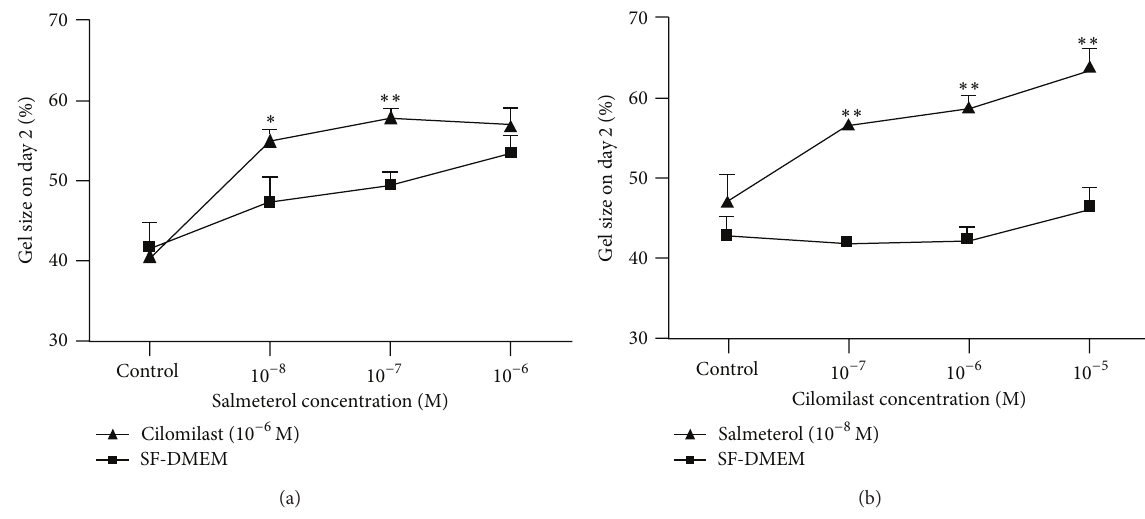
Figure 2: Cilomilast potentiates the inhibitory effect of salmeterol on fibroblast-mediated collagen gel contraction. (a) Effect of cilomilast on varying concentrations of salmeterol. HFL-1 cells were cast into collagen gels and released into SF-DMEM containing varying concentrations (0, 10 −8 , 10 −7 , and 10 −6 M) of salmeterol in the presence or absence of cilomilast (10 −6 M). Vertical axis: gel size on day 2 (%); horizontal axis: salmeterol concentration (M). Square: SF-DMEM only; triangle: in the presence of 10 −6 M cilomilast. ∗ 𝑃 < 0.05 ; ∗∗ 𝑃 < 0.01 compared to salmeterol only. (b) Effect of salmeterol in the presence of varying concentrations of cilomilast. HFL-1 cells containing collagen gels were released into SF-DMEM supplemented with 10 −8 M salmeterol in the presence or absence of varying concentrations (0, 10 −7 , 10 −6 , and 10 −5 M) of cilomilast. Vertical axis: gel size on day 2 (%); horizontal axis: cilomilast concentrations (M). Square: SF-DMEM only; triangle: in the presence of salmeterol (10 −6 M). ∗∗ 𝑃 < 0.01 compared to cilomilast alone at each time